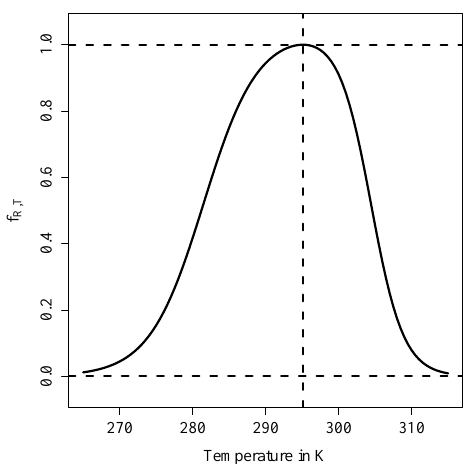
Fig. 2. Function describing the influence of relative humidity on the release of birch